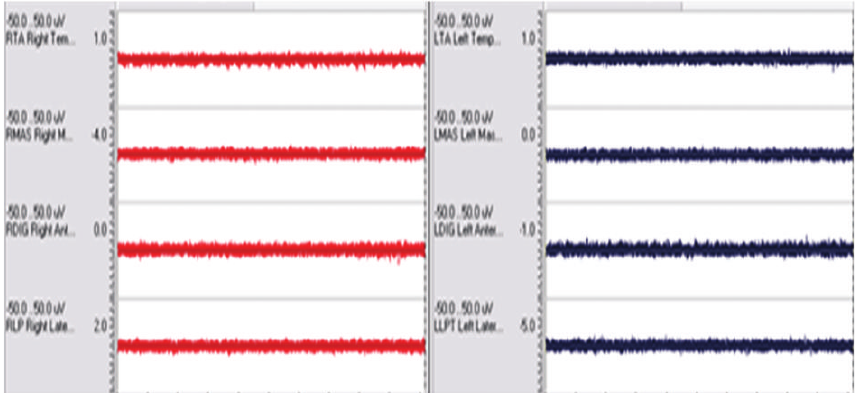
Figure 5: SEMG activity of the bilateral temporalis anterior (TA), masseter (MAS) suprahyoid (DIG), and lateral pterygoids (RLP/LLPT) after 25 minutes of ULF-TENS. Recording demonstrates that baseline levels from all sites are low and balanced.